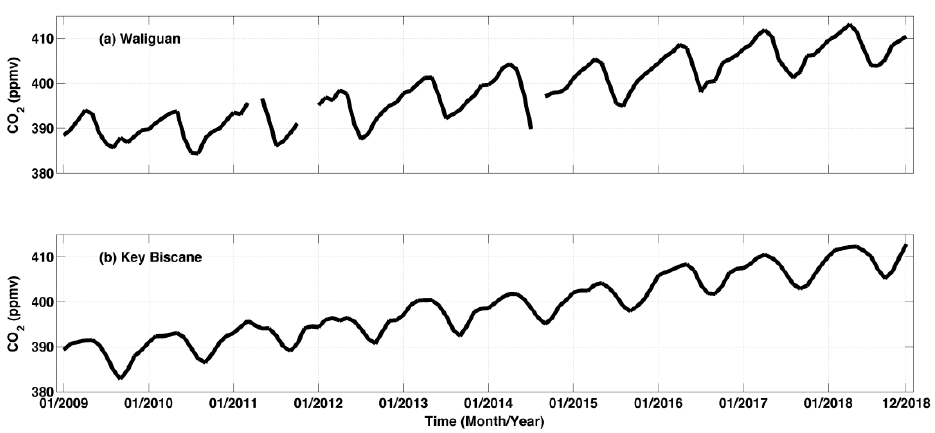
Figure 1. Monthly mean CO 2 mole fractions at ( a ) Waliguan and ( b ) Key Biscayne from 2009 to 2018.